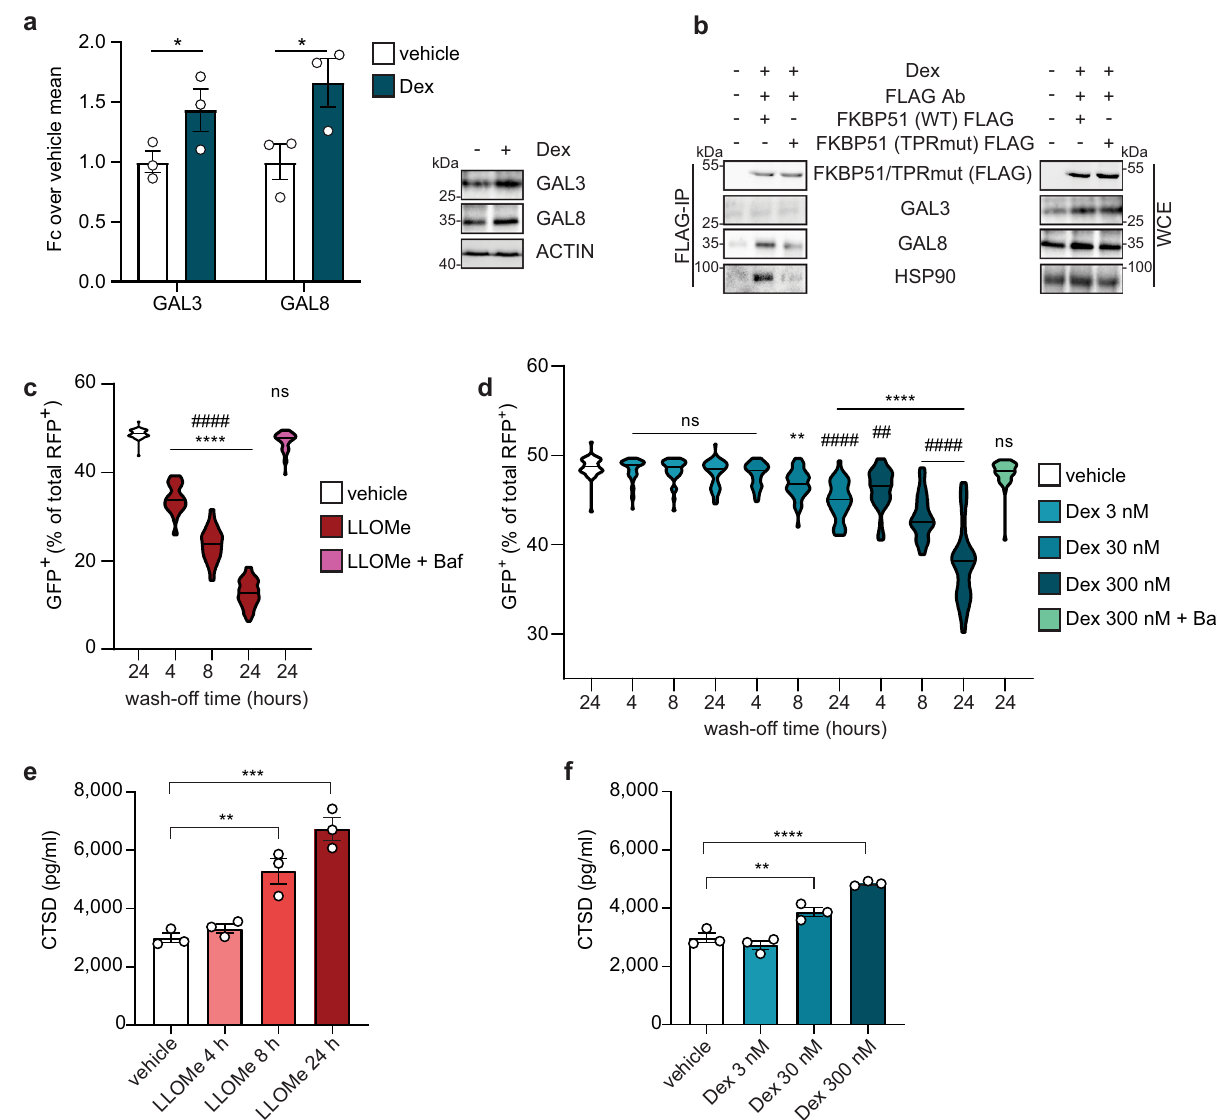
Fig. 2 FKBP51 mediates regulatory mechanisms underlying secretory autophagy. a Quanti fi cation of western blot analyses and representative blots of GAL3 and GAL8 normalized to actin from WT cells treated with 100 nM dexamethasone (Dex) or vehicle for 4 h. n = 3 biologically independent samples. Unpaired, one-tailed t -tests were performed; * p < 0.05. Data shown as mean ± s.e.m. b Western blotting of FKBP51, GAL3, GAL8, and HSP90 in FLAG- tagged WT or mutant (TPRmut) FKBP51 co-IP (FLAG-IP) and whole cell extract (WCE) as control performed in cells treated with 100 nM dexamethasone or vehicle. c , d Quanti fi cation of GFP + puncta expressed as a percentage of total RFP + puncta in cells ( n = 40 cells per group) transfected with tfGal3 construct and treated with 1 mM LLOMe or 300 nM dexamethasone (Dex) for 3 h, followed by 4, 8, and 24 h wash-off, and with co-treatment of ba fi lomycin (Baf) for 3 h followed by 24 h wash-off. Kruskal – Wallis multiple comparison test was performed; ** P < 0.01; **** P < 0.0001. Asterisk symbol indicates comparisons to vehicle; hash symbol indicates comparisons to treatment + Baf. a – d All experiments were performed in SH-SY5Y cells. e , f CTSD from supernatants measured via ELISA after SIM-A9 cells were treated with LLOMe for 4, 8, and 24 h or vehicle for 24 h, or with 3, 30, and 300 nM Dex or vehicle for 4 h. n = 3 per group. Tukey ’ s multiple comparison test was performed; ** P < 0.01; *** P < 0.001; **** P < 0.0001. Only signi fi cant comparisons are shown. Data shown as mean ± s.e.m. Fc fold change, Ab